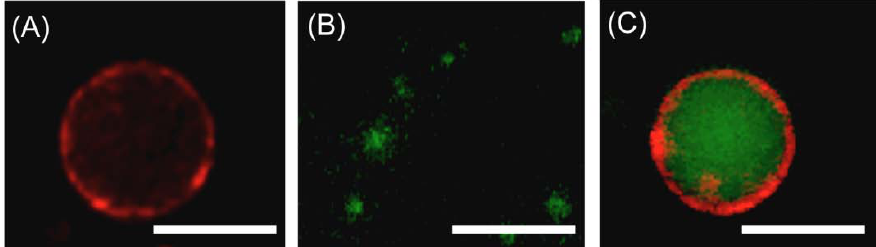
Figure 7. Fluorescence microscopic images of a giant liposome composed of 1 and 2 at a 2/8 molar ratio and labeled with Rh-PE ( A ), small unilamellar liposomes at a 5/5 molar ratio and labeled with rhodamine 123 ( B ), and their 1/9 (v/v) mixture with PVSK ( C ). Concentrations in mM: [ 1 ]+[ 2 ], 1.0 and [PVSK], 0.80 (per monomer unit); scale bar, 10 µ